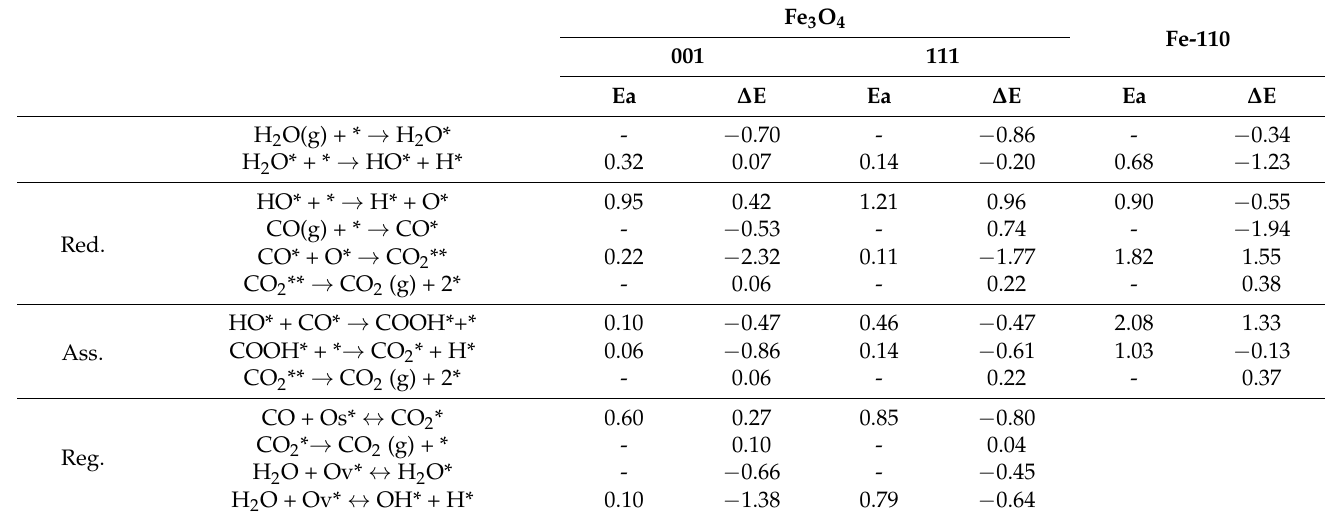
Table 1. Reaction energy and barrier comparison of H 2 O dissociation and CO 2 formation on Fe (110) and Fe 3 O 4 (111)-Fe tet1 and (001)-B.